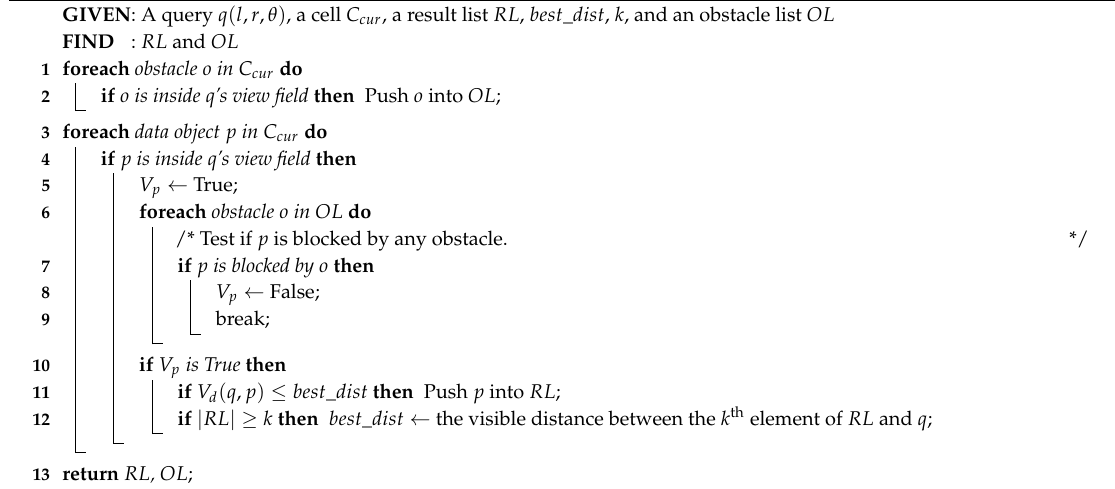
Algorithm 2. Visibility Check (VC) algorithm.